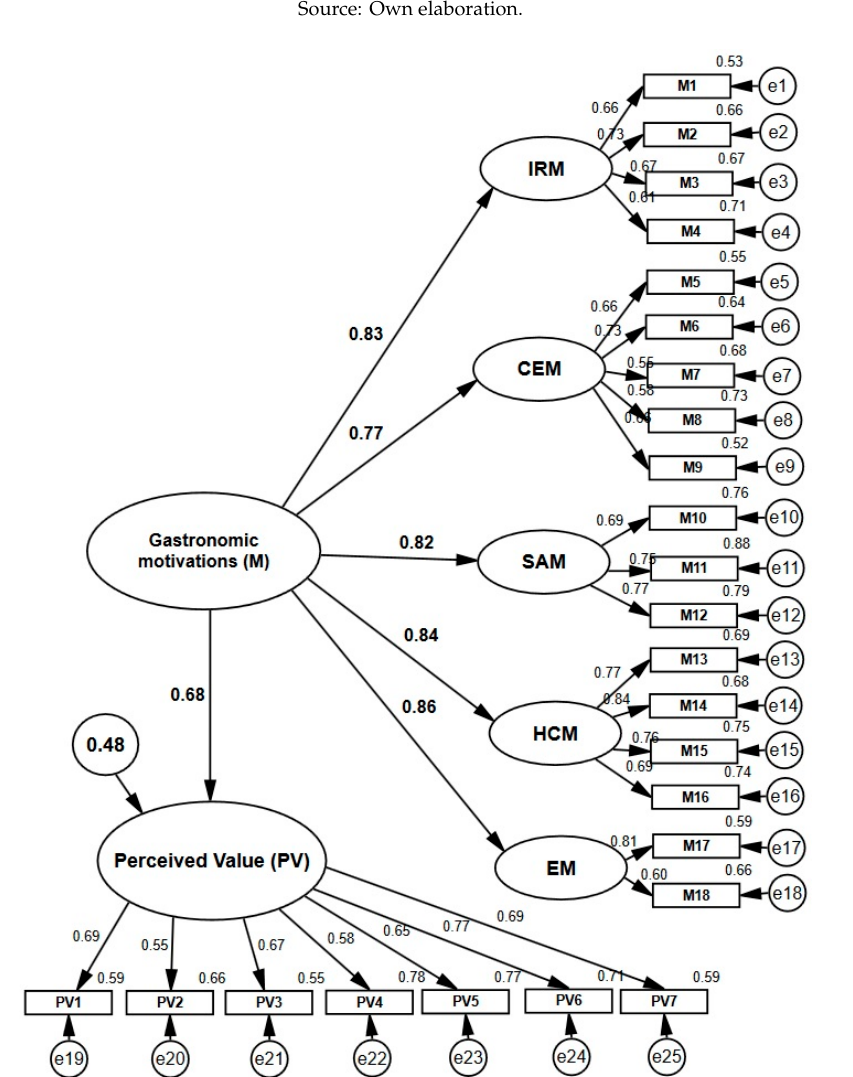
Figure 4. Effect of gastronomic motivations on perceived value. IRM: Interpersonal relationship